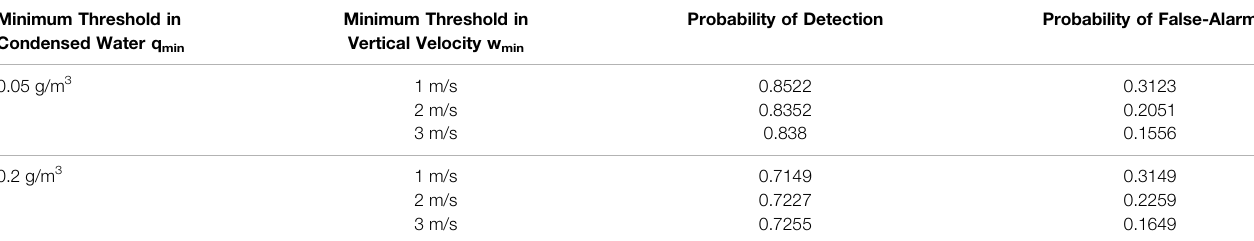
TABLE 2 | Probabilities of detection/false-alarm of non-shallow convective core from measurements of a pair of radiometers, according to different minimum thresholds in condensed water q min and vertical velocities w min